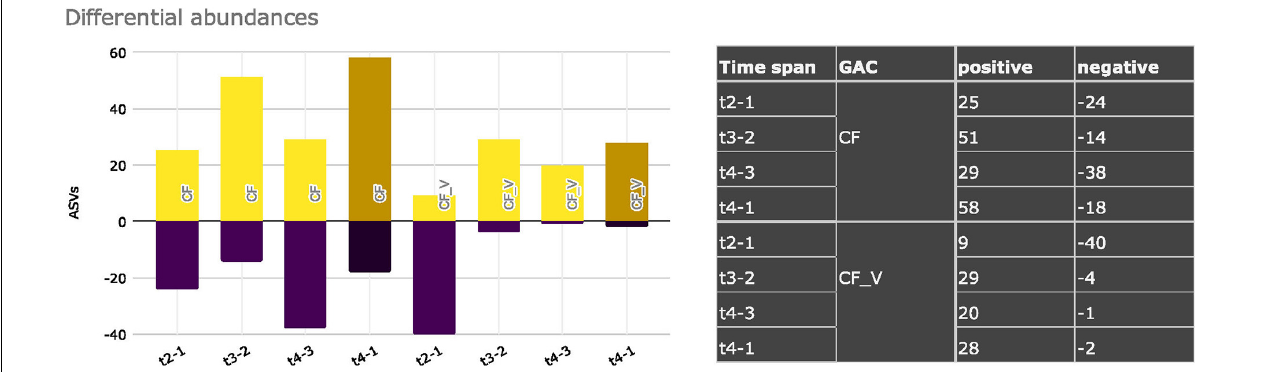
FIGURE 7 | Significant differential ASVs abundances considering mineral GACs (CF) and vegetal GACs (CF_V), comparing different sampling dates. Positive and negative variations are shown.